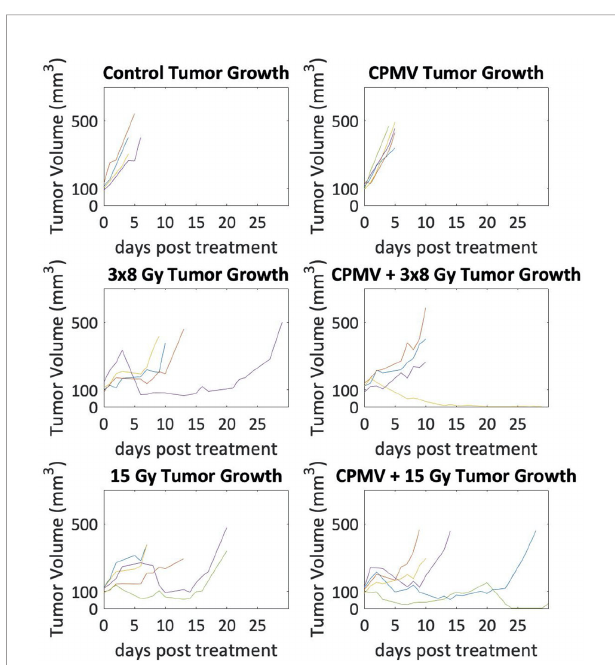
FIGURE 6 | Tumor Growth Curves. Tumor growth curves for each animal with tumor volume on a logarithmic scale. Control and Cowpea mosaic virus (CPMV) tumor growth are exponential as the lines appear linear, whereas in the radiation cohorts there are several animals that do not follow exponential growth. Additionally, in the combinatorial CPMV and radiation cohorts there were a few animals whose tumor volumes decreased towards